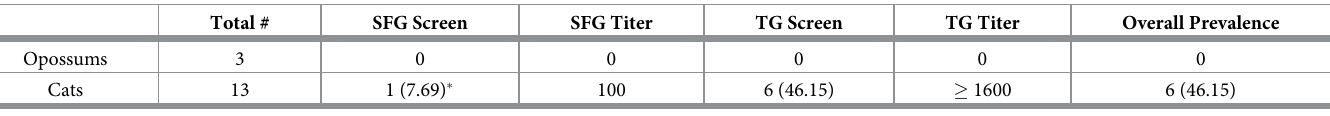
Table 4. Summary of percent (%) prevalence of IgG antibodies in 3 opossums and 13 cat sera from animals collected at the mobile home community in Los Angeles County,